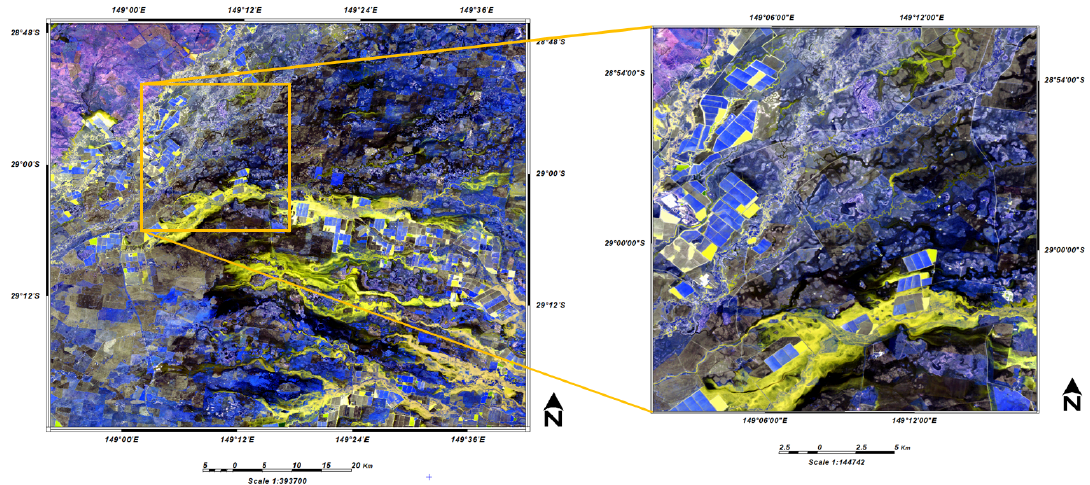
Figure 2. Landsat-5 TM surface reflectance image acquired on 12 December 2004 for the Lower Gwydir Catchment study site ( left ) located in northern New South Wales, Australia and the test area for this study ( right ).